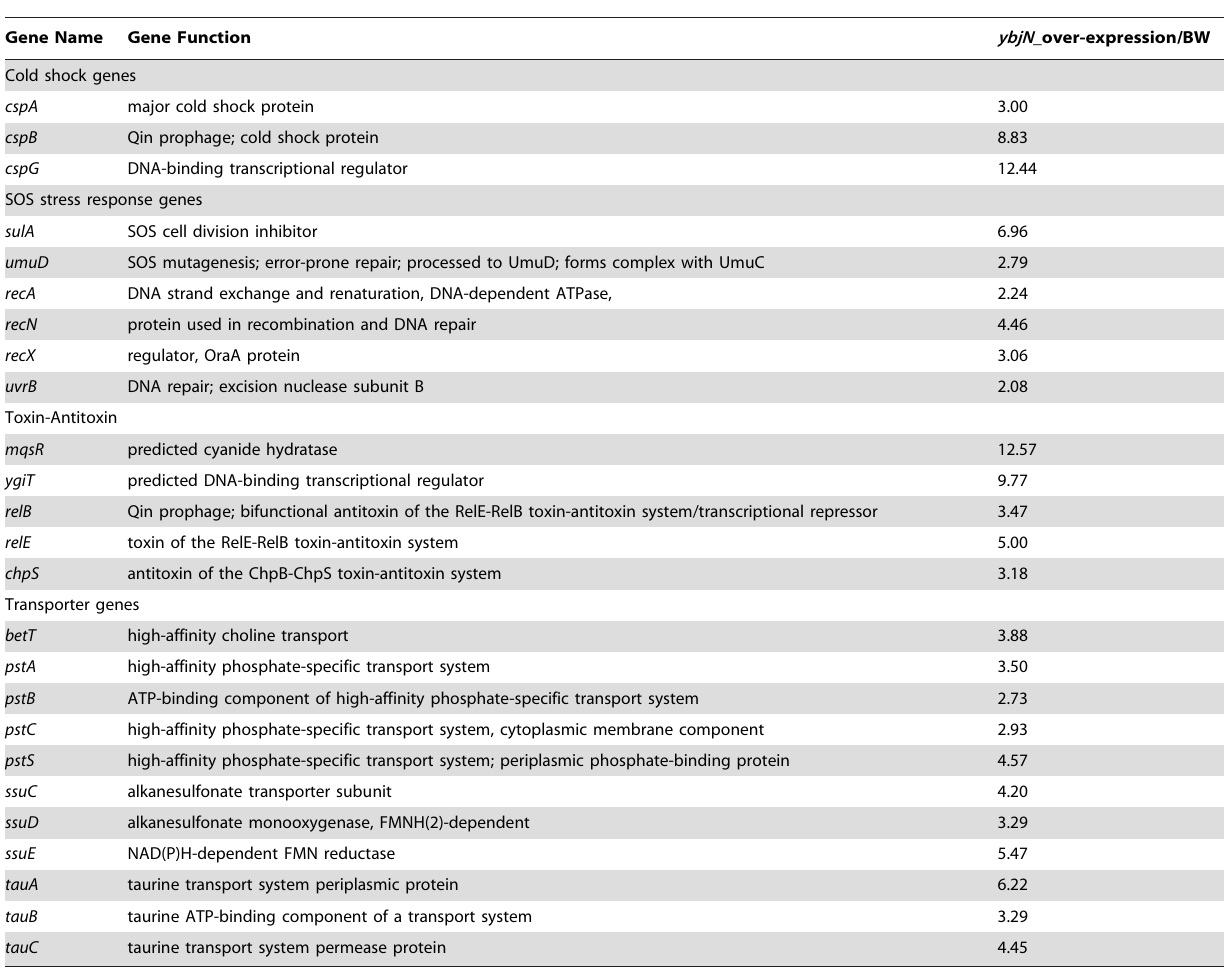
Table 2. Stress responsive genes that are induced by ybjN over-expression (p-value , 0.05).